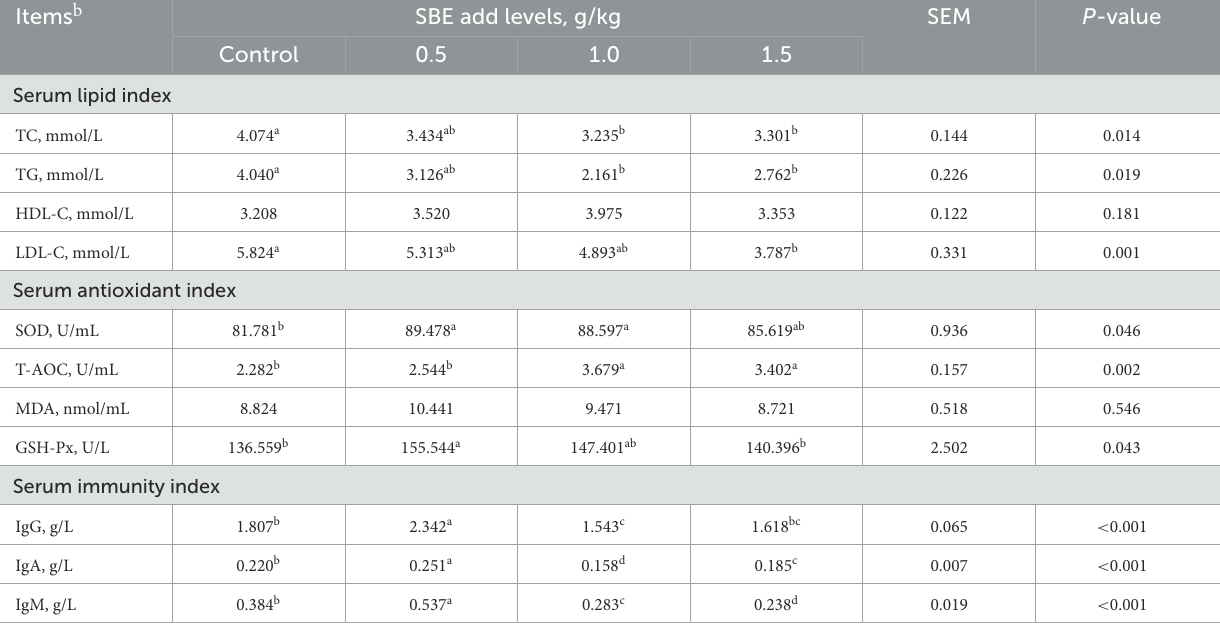
TABLE 3 Effect of dietary SBE on serum biochemical indexes of laying ducks a